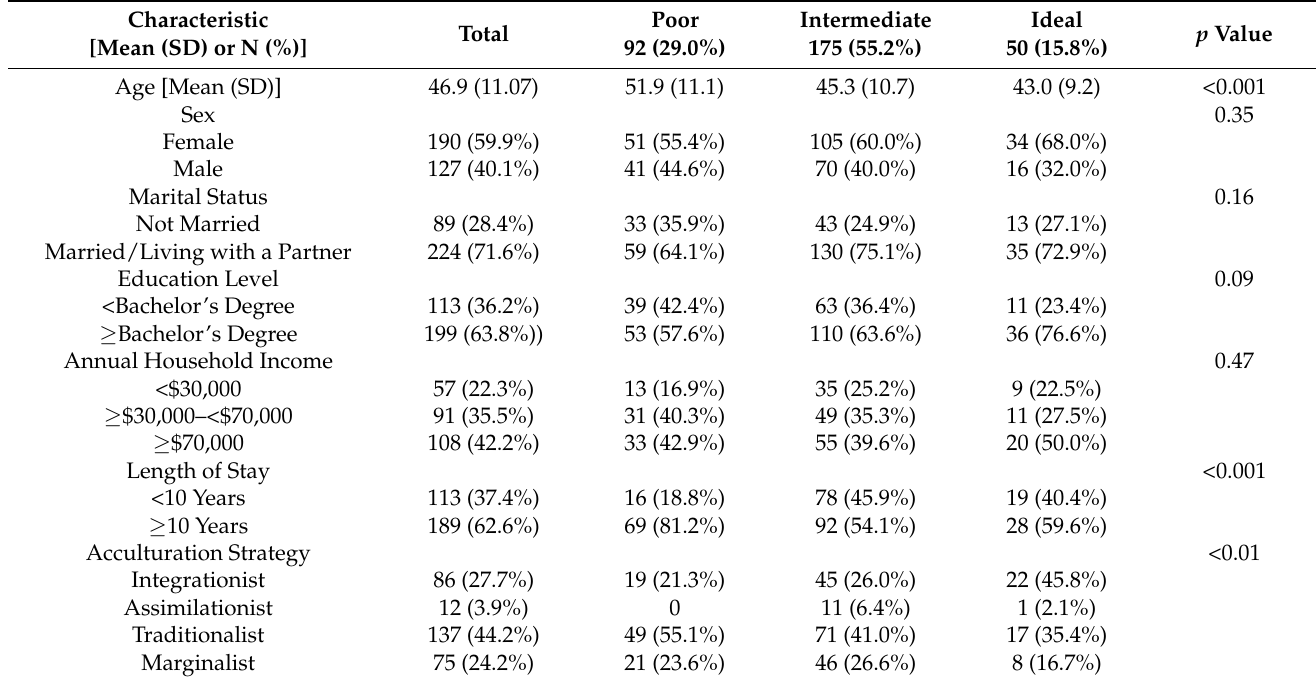
Table 1. Sociodemographic Characteristics of Study Participants by CVH status, n =